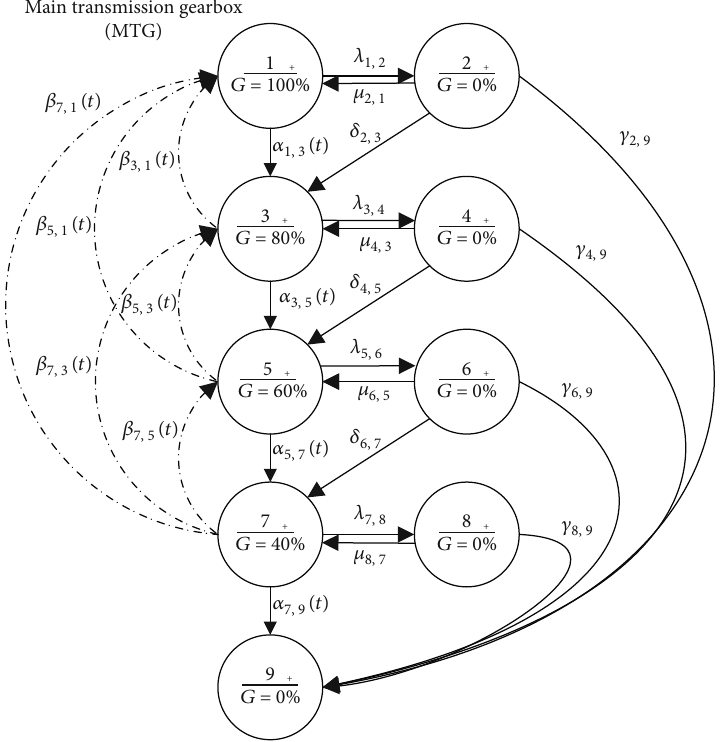
Figure 5: State-transition diagram of main transmission